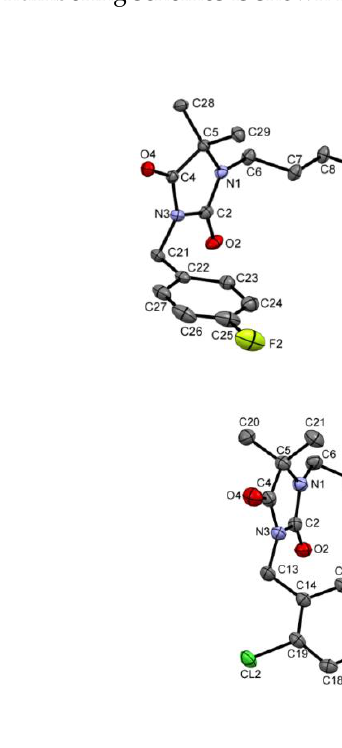
Figure 1. The molecular geometry with the atom numbering schemes of: ( a ) 6 ; and ( b ) 15 . Hydrogen atoms have been omitted for clarity. Displacement ellipsoids are drawn at the 50% probability level. Orange dashed lines show hydrogen bonds between the chloride anion and protonated N2 atom for both structures and between the chloride anion and hydroxy group in 15.